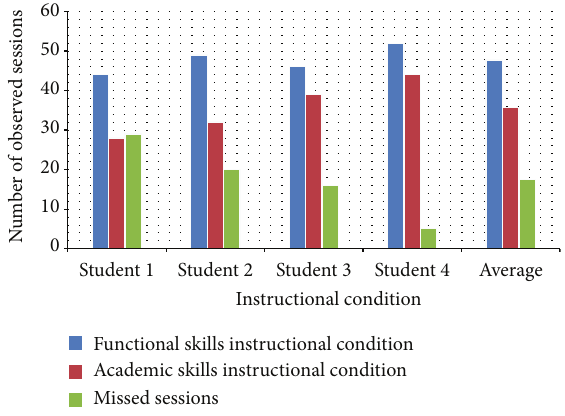
Figure 1: Total number of observation sessions for each